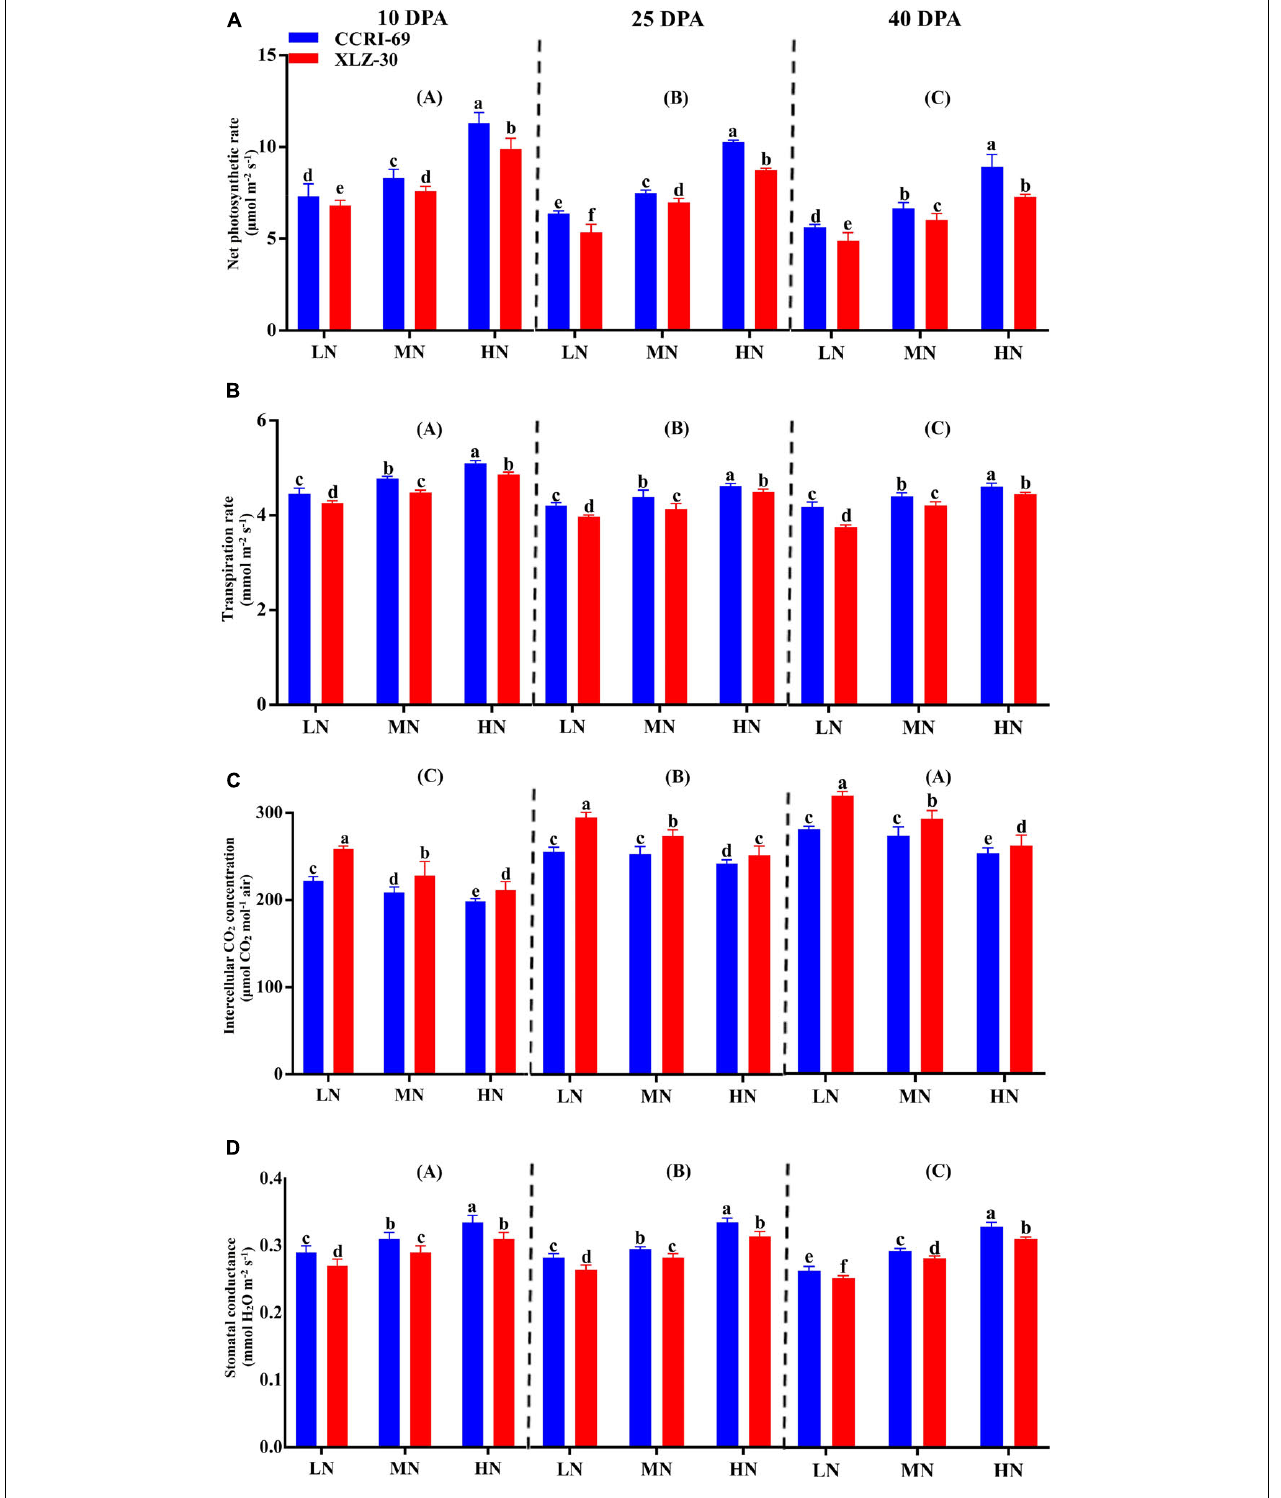
FIGURE 2 | (A–D) Net photosynthetic rate ( µ mol m − 2 s − 1 ), transpiration rate (mmol m − 2 s − 1 ), intercellular CO 2 concentration ( µ mol CO 2 mol − 1 air), and stomatal conductance (mmol H 2 O m − 2 s − 1 ) of cotton subtending leaves of CCRI-69 and XLZ-30 in response to low (LN; 0.25 mM), moderate (MN; 2.5 mM), and high (HN; 5 mM) N levels at 10, 25, and 40 days post-anthesis (DPA). Error bars with different small letters show significant differences between genotypes under different N levels, and capital letters in the brackets show significant differences among growth stages (10, 25, and 40 DPA) at p < 0.05.